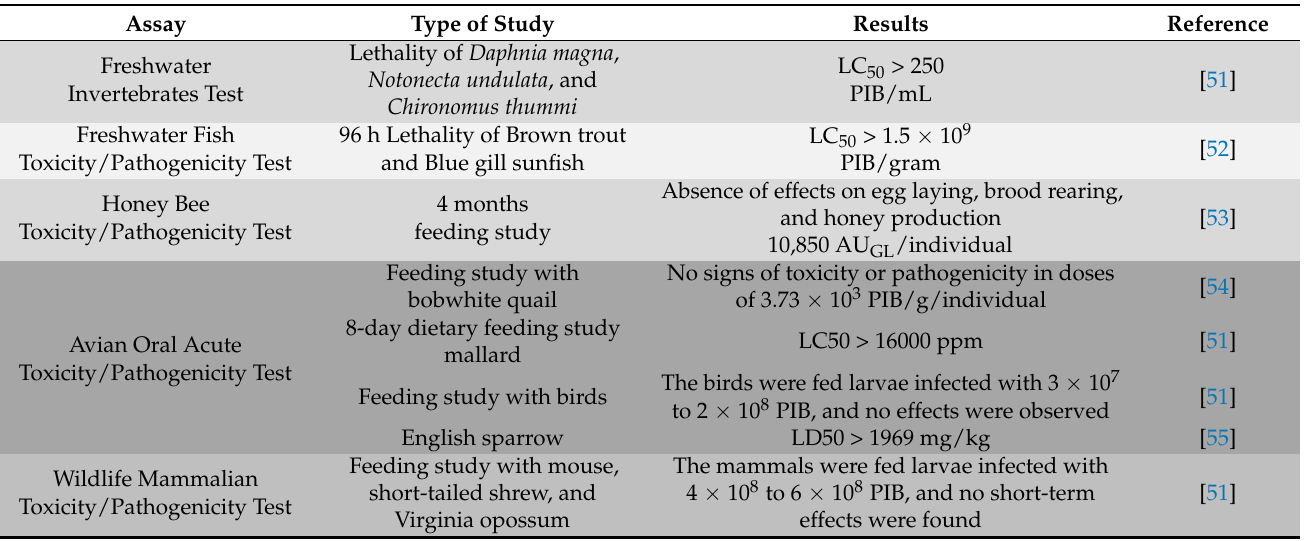
Table 3. Results of ecotoxicity assays of the Nucleopolyhedrovirus Lymantria dispar and Orgyia pseudotsugata on non-target